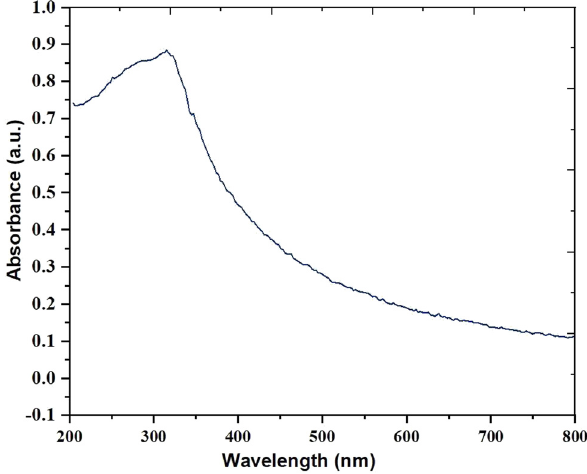
Figure 1: UV - vis spectra of ZnO NPs synthesized from the extract of pumpkin